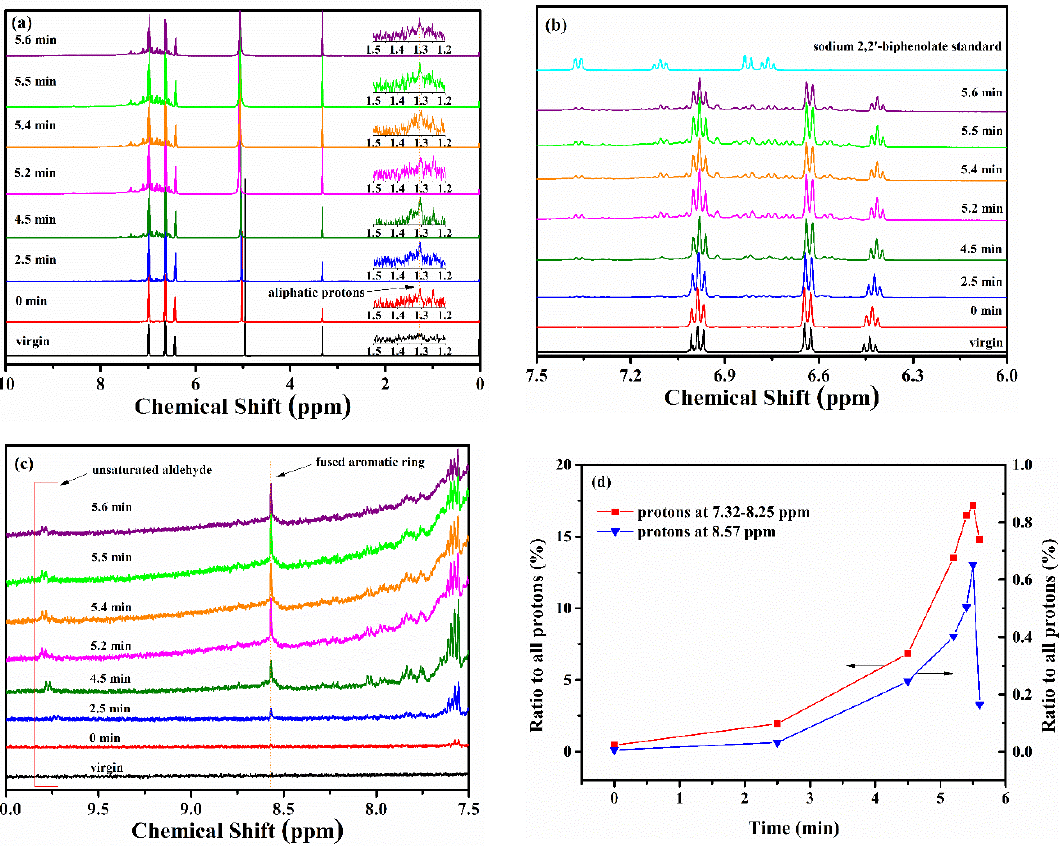
Figure 2. FTIR spectra of sodium phenolate (soluble part) with time at 495 °C.